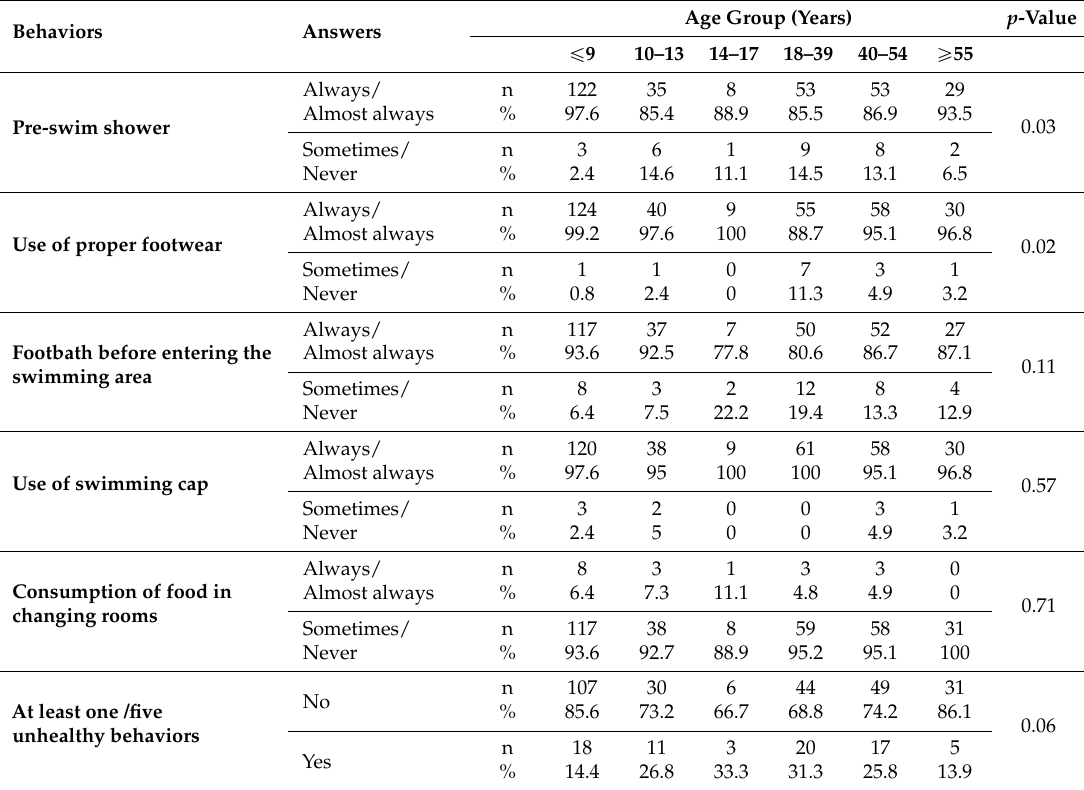
Healthy behaviors adopted by participants in swimming pools by age group with corresponding p